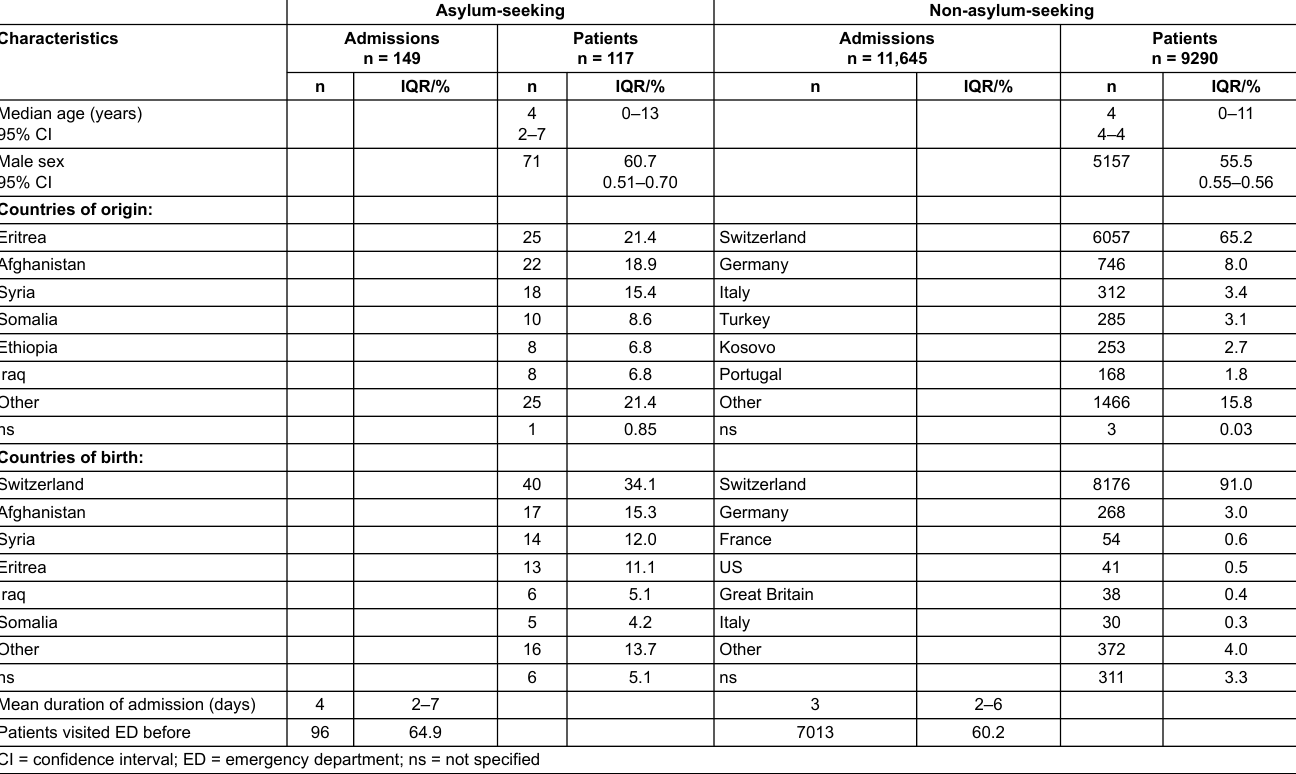
Table 1: Baseline characteristics, countries of origin, native country by asylum-seeking and non-asylum-seeking patients in 2016/17.